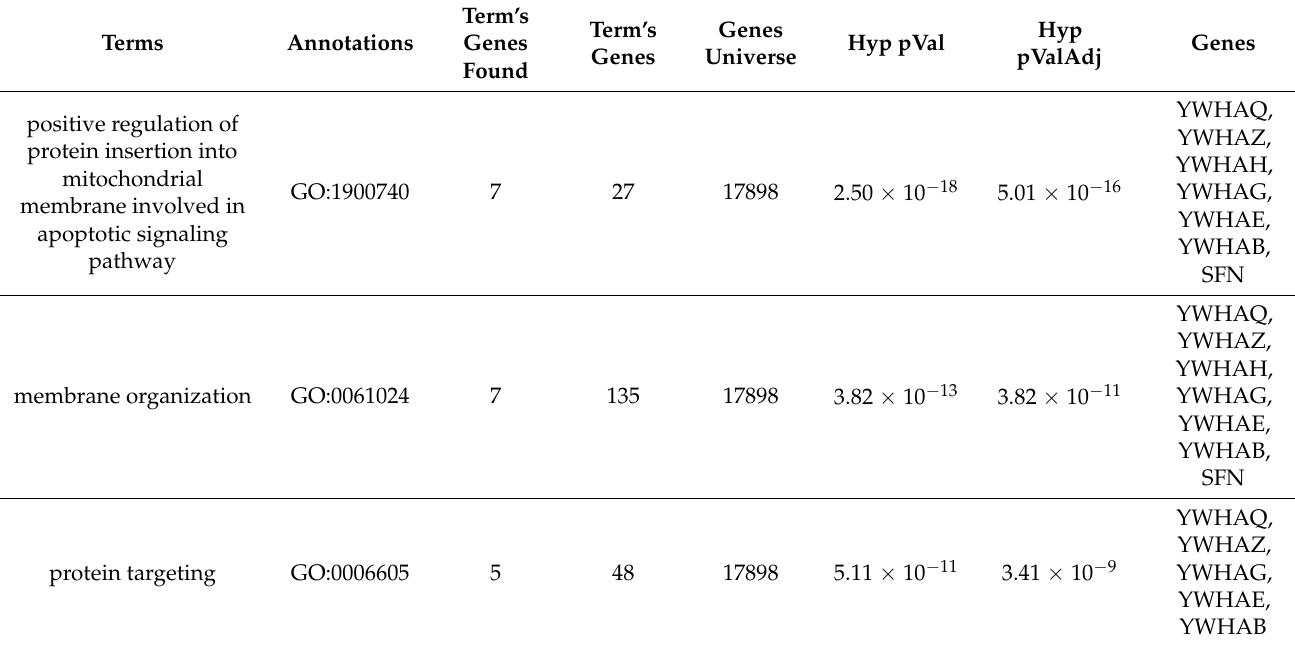
Table 6. The top 5 annotations identified by the GeneCodis FEA for BP